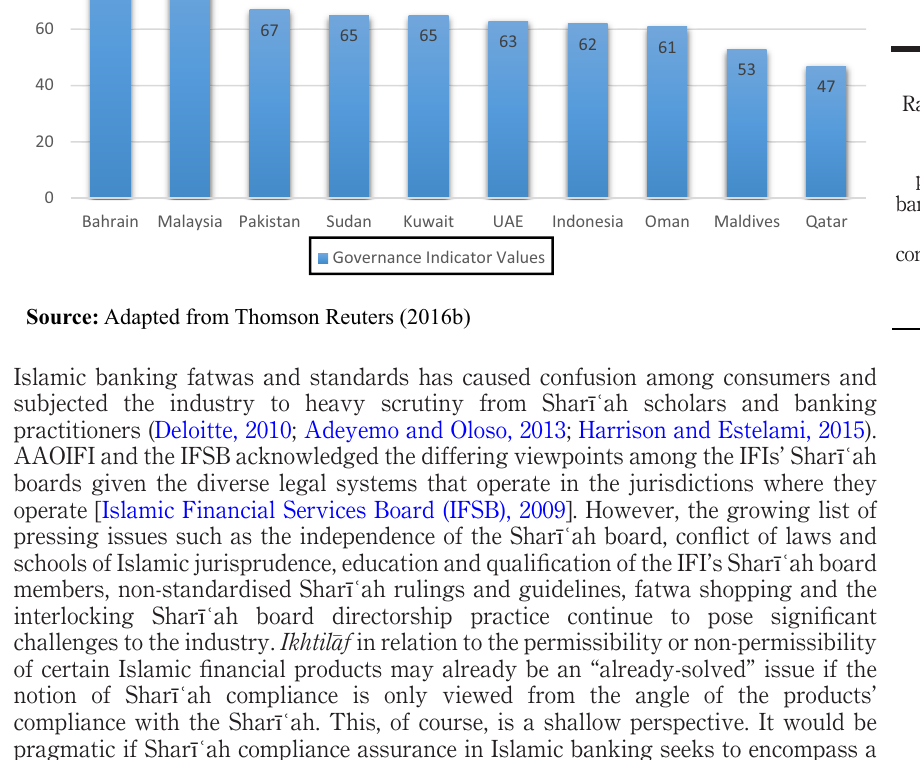
Figure 1. Ranking of